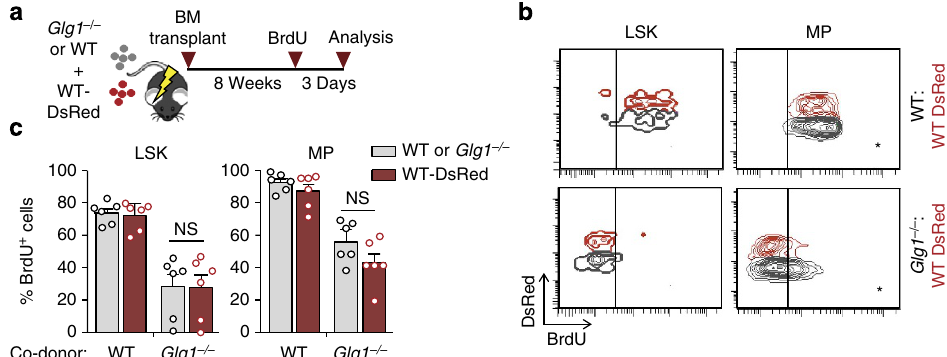
Figure 2 | Deficiency in haematopoietic ESL-1 generates a quiescent bone marrow environment. ( a ) Experimental scheme for the generation of mixed chimeric mice by bone marrow transplantation. ( b ) Representative plots of BrdU incorporation in LSK and myeloid progenitors (MPs) in WT:WT-DsRed or Glg1 (cid:2) / (cid:2) :WT DsRed chimeric mice. ( c ) Percentage of BrdU-incorporating WT-DsRed and Glg1 (cid:2) / (cid:2) cells in the mixed chimeric mice shown in b ; n ¼ 6. NS, not significant. Each circle represents a mouse. Bar graphs show mean ±